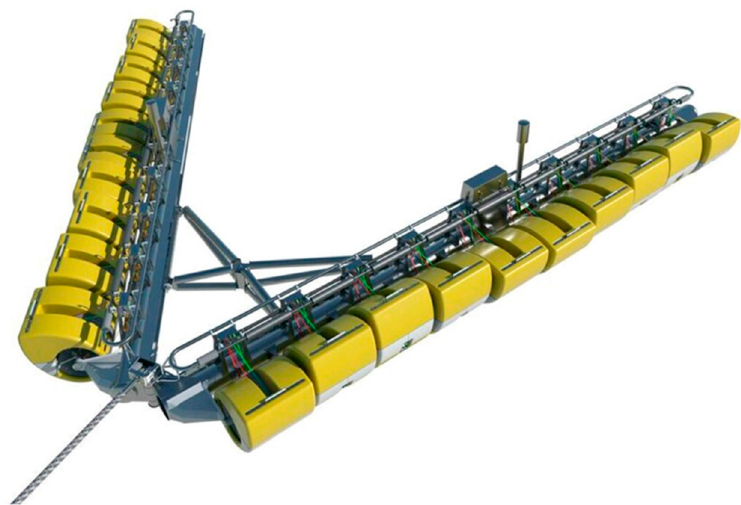
Figure 1. Weptos WEC.